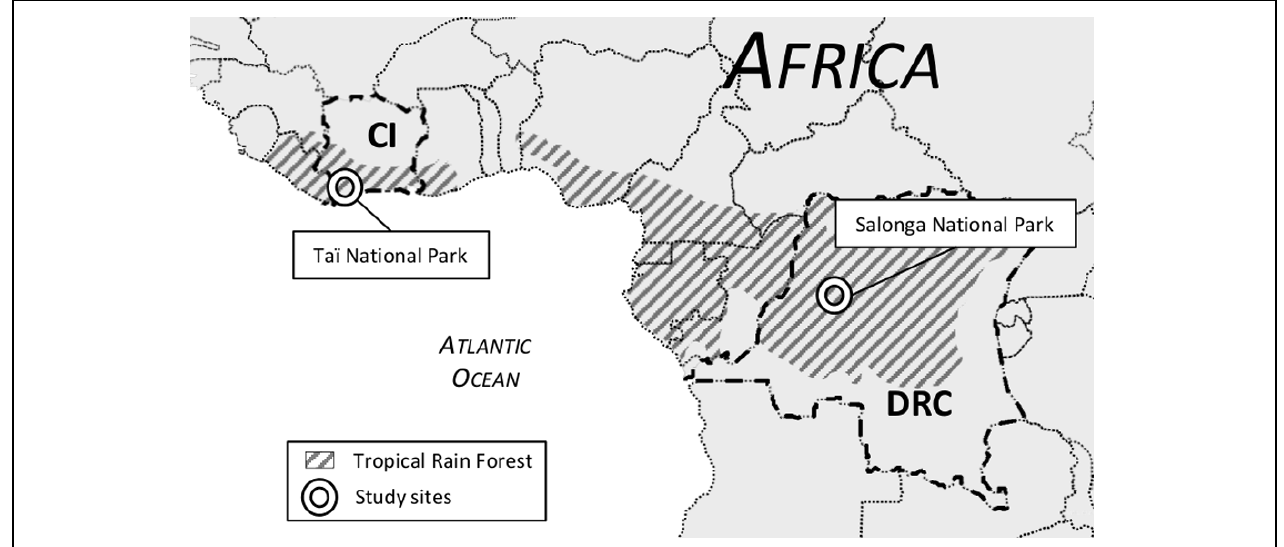
FIGURE 1 | Map of Western/Central Africa showing location of study sites illustrated by circles. The shaded areas mark tropical rain forest biome. CI, Côte d’Ivoire; DRC, Democratic Republic of Congo.